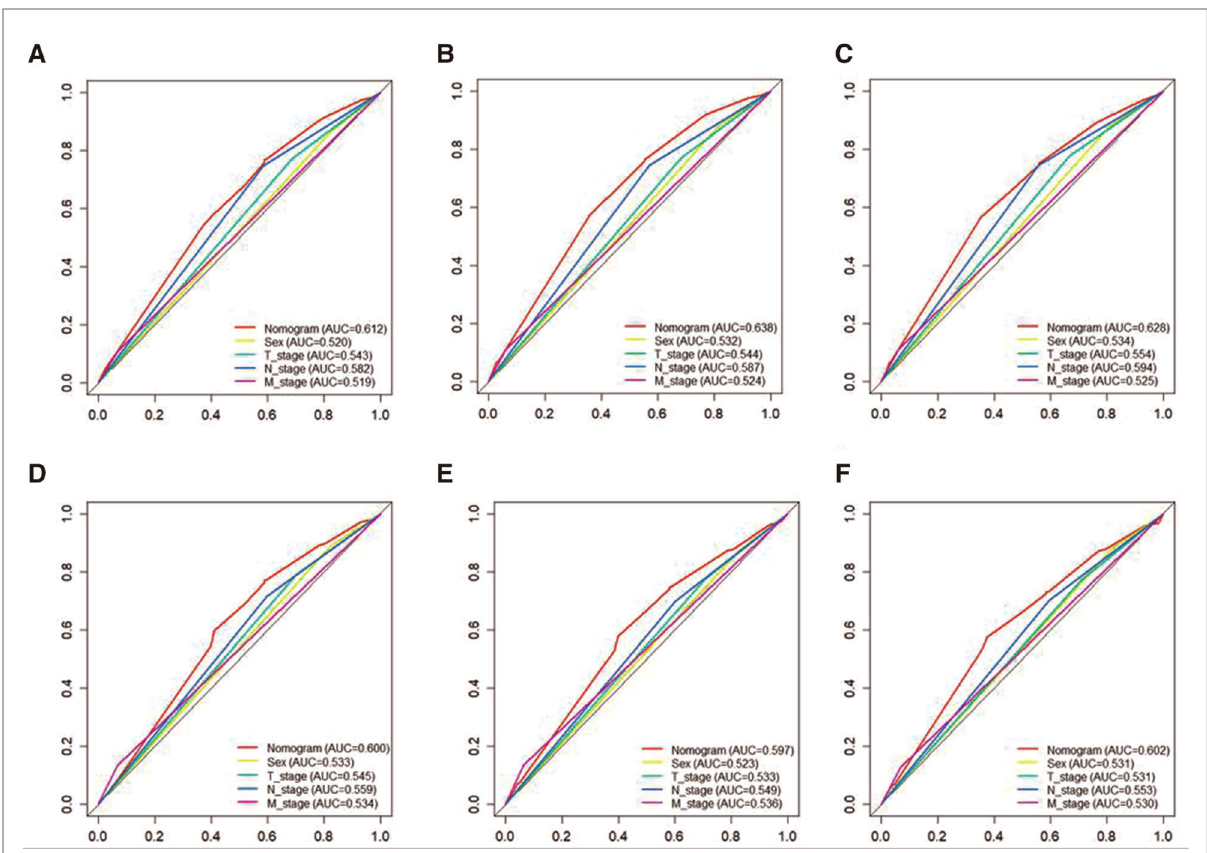
FIGURE 4 The ROC curves for CSS, including the nomogram model and all independent predictors at 3- ( A ), 5- ( B ), and 7-years ( C ) in the training cohort and at 3- ( D ), 5- ( E ), and 7-years ( F ) in the validation cohort. ROC, Receiver operating characteristic; CSS, cancer speci fi c